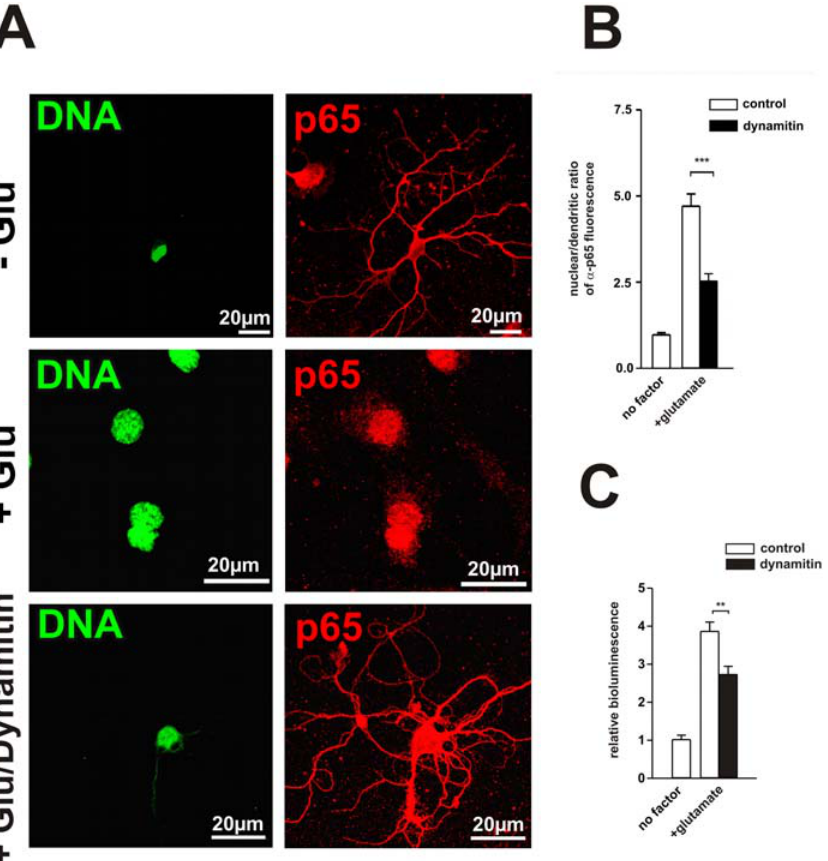
Figure 3. Inhibition of dynein function by overexpression of dynamitin impairs nuclear accumulation of NF- k B and reduces NF- k B-dependent transcription activity. (A) Cultured hippocampal neurons transfected with dynamitin or mock vector were left untreated or incubated with 300 m M glutamate for 5 min. After 90 min neurons were fixed and analyzed for subcellular NF- k B p65 destribution. Nuclei were stained with SYTOX (green). Anti-p65 immunoreactivity is depicted in red. (B) Quantification of nuclear/dendritic ratio of a -p65 fluorescence in dynamitin-transfected and control- transfected neurons with and without glutamate stimulation. Note that transfection with dynamitin impaired redistribution of NF- k B p65 from distal sites to the nucleus following glutamate stimulation. Fluorescence measurements were made from 20 to30 neurons in each experimental condition. (C) Reporter gene assay showed reduced NF- k B-dependent transcription activity in neurons overexpressing dynamitin.